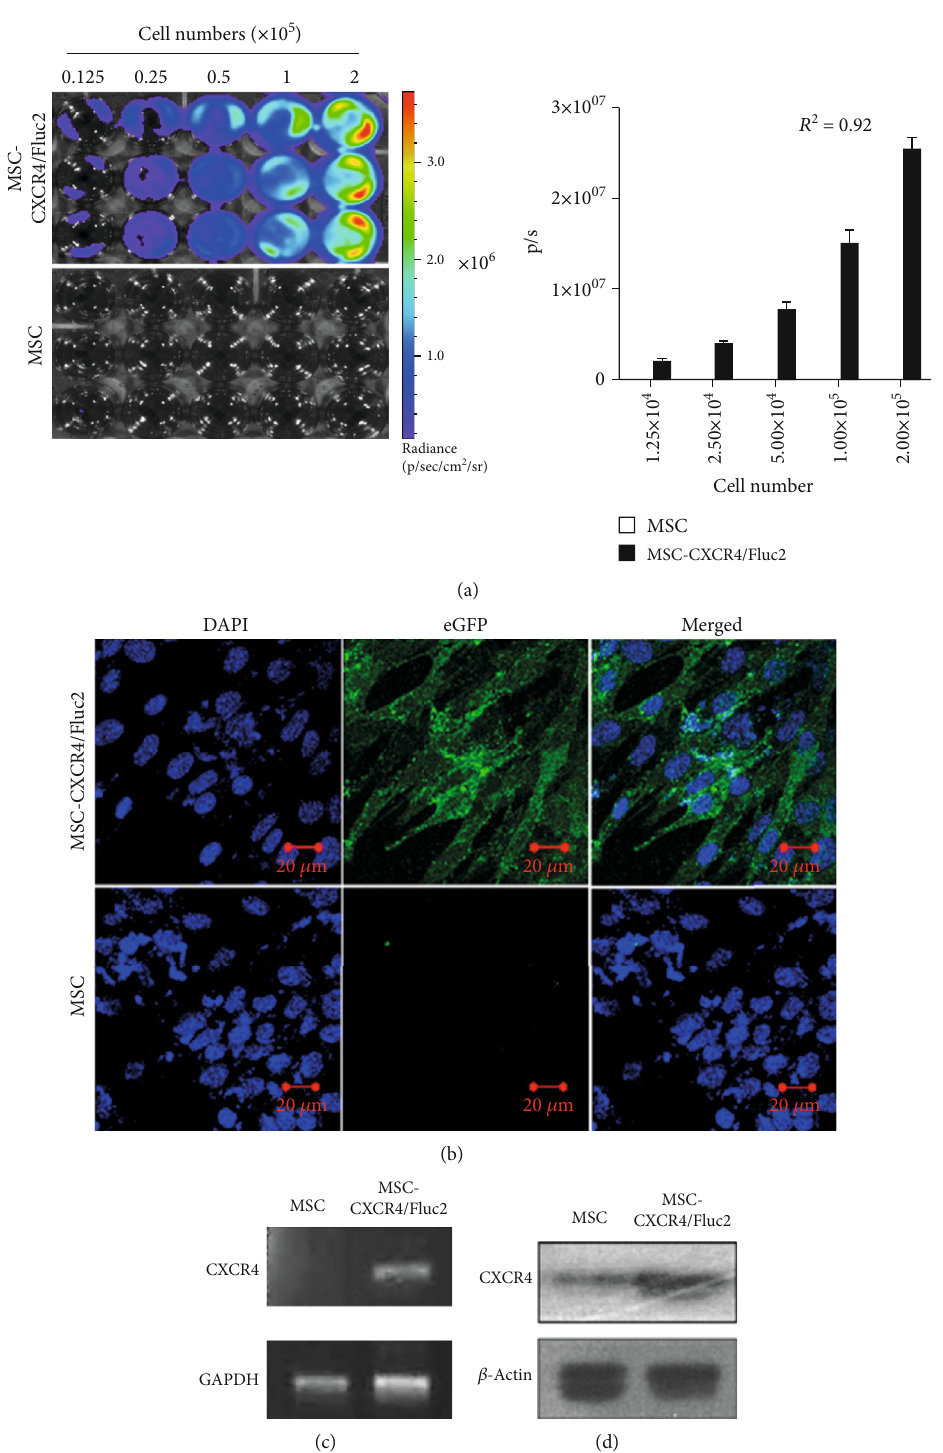
Figure 1: Transduction of CXCR4 in mesenchymal stromal cells (MSCs) with reporter genes. (a) Fluc activity and quantitative bioluminescent imaging (BLI) data of CXCR4-transduced MSCs with di ff erent cell numbers. (b) Enhanced green fl uorescent protein (eGFP) expression analysis by confocal microscopy imaging and (c) CXCR4 mRNA expression analysis by RT-PCR. (d) Protein expression of CXCR4 by Western blot